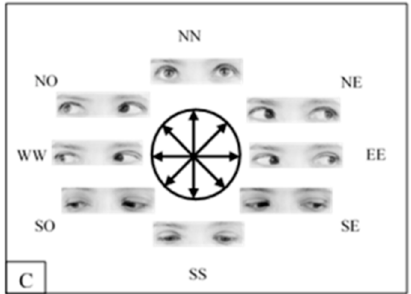
Figure 6. The three types of stimuli used in Actis-Grosso and Ricciardelli [33]. Each panel displays the eight directions conveyed by the different stimuli and the eight possible positions of stimulus presentation.